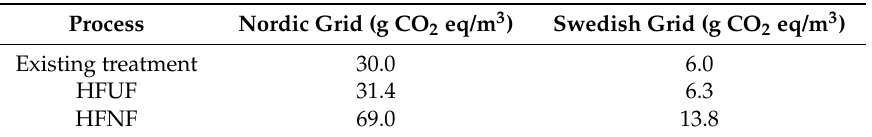
Table 2. GHG emissions from the energy